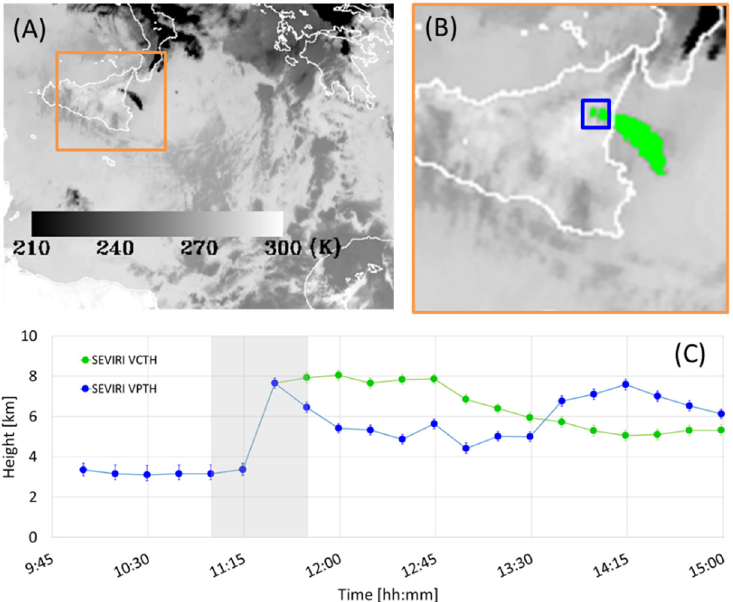
Figure 5. ( A ) Brightness temperature at 10.8 μ m considering the SEVIRI image collected on 24 December 2018 at 12:00. ( B ) Image of Sicily with the blue square area and the green area used for the Volcanic Plume Top Height (VPTH) and Volcanic Cloud Top Height (VCTH) computation, respectively. ( C ) Plot of VPTH (blue points-line) and VCTH (green points-line) time series obtained from SEVIRI data collected every 15 min on 24 December 2018. The green and blue vertical bars represent the VCTH and VPTH SEVIRI retrieval uncertainties, respectively.